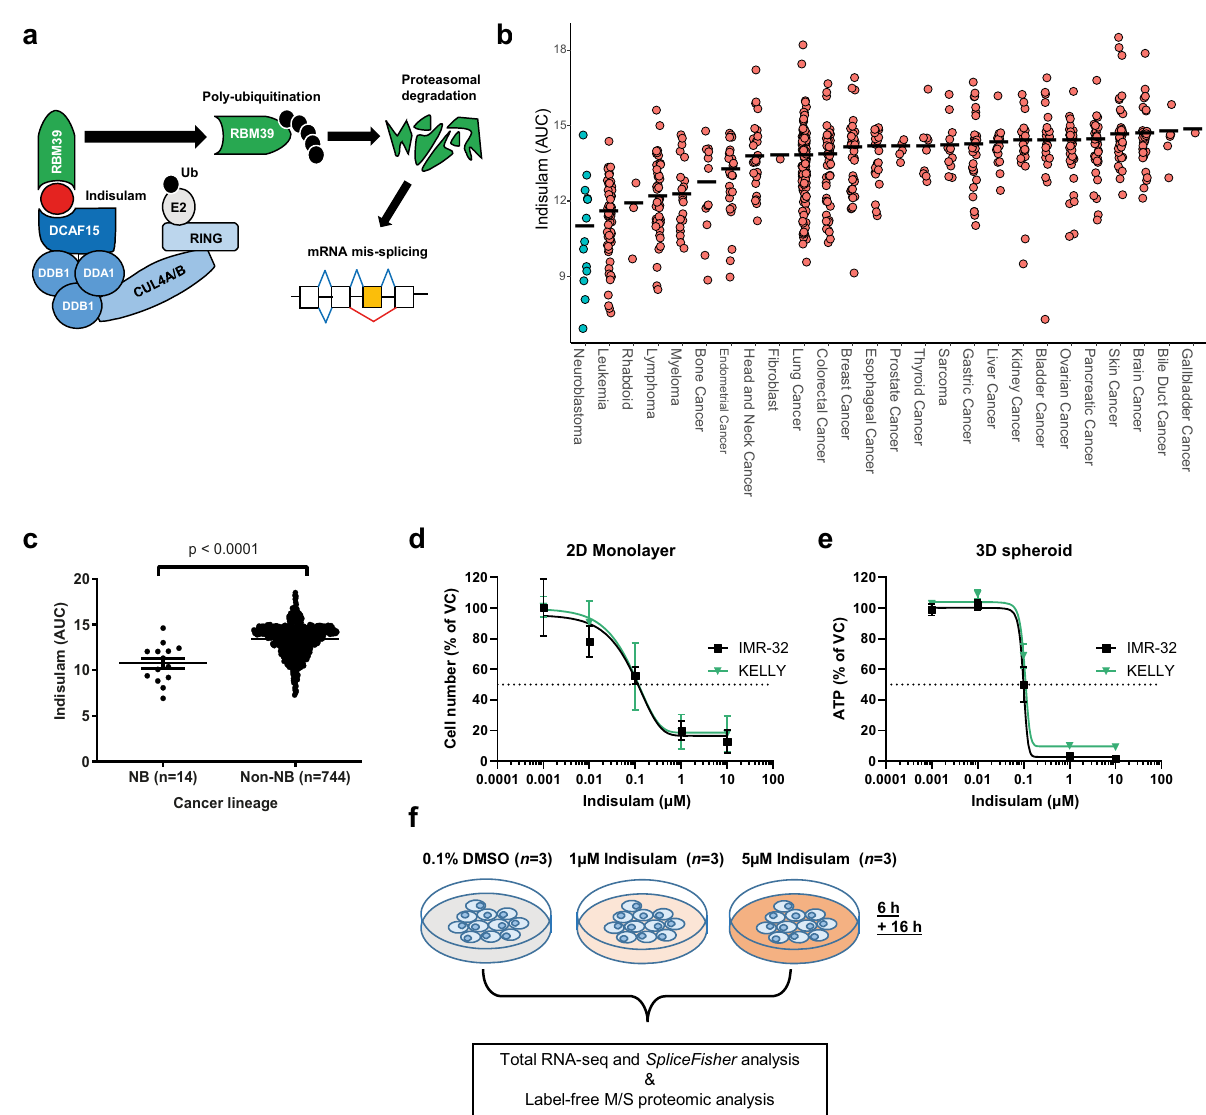
Fig. 1 Indisulam is highly ef fi cacious in in vitro models of neuroblastoma. a Aryl sulfonamides such as indisulam (red) act as a molecular glue bringing together DCAF15 E3 ubiquitin ligase and RNA binding protein RBM39 resulting in poly-ubiquitination and degradation of the protein. Depletion of RBM39 leads to aberrant splicing defects. b . Median indisulam area-under-curve (AUC) in cell lines from 26 tumour origins. Data was acquired from the CTD 2 network 24 , each circle represents one cell line. c Indisulam AUC of 14 neural-crest derived neuroblastoma (NB) compared to non-NB cell lines (all other cancer lineages, n = 744 cell lines). Each circle represents one cell line. Data were acquired from the CTD 2 network 24 d Neuroblastoma lines IMR-32 and KELLY were treated with a 5-point dose-response of indisulam or vehicle control (VC, 0.1% DMSO) for 72 h. Cell growth determined by SRB assay ( n = 3 independent experiments). e IMR-32 and KELLY cells were grown in 3D spheroids and treated with indisulam or VC (0.1% DMSO) for 72 h. ATP was measured with Cell-Titre-Glo 3D. (IMR-32 n = 3 independent experiments, KELLY n = 2 independent experiments). f Overview of work fl ow of proteomic and RNAseq analysis in IMR-32. Data are represented as mean values ± SD. d , e Statistical signi fi cance in c was determined by a Mann Whitney test. Source data is provided as a Source Data